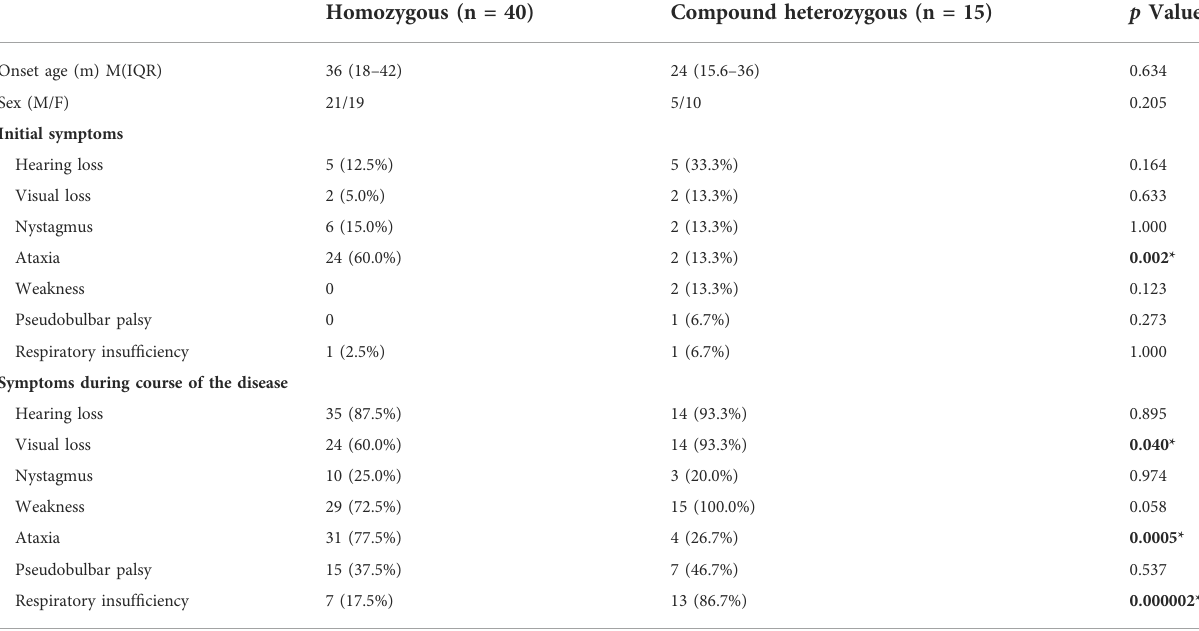
TABLE 1 Comparison of the clinical characteristics of patients with SLC52A2 gene homozygous mutations and compound heterozygous